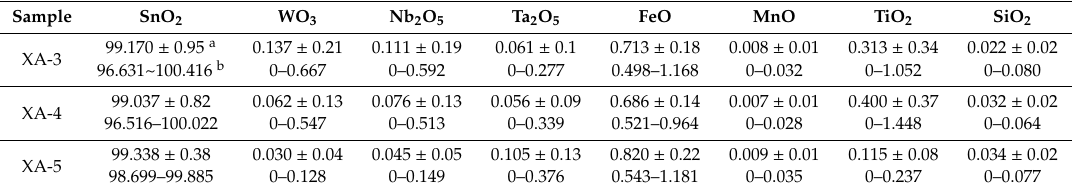
Table 4. Statistical characteristics of EPMA